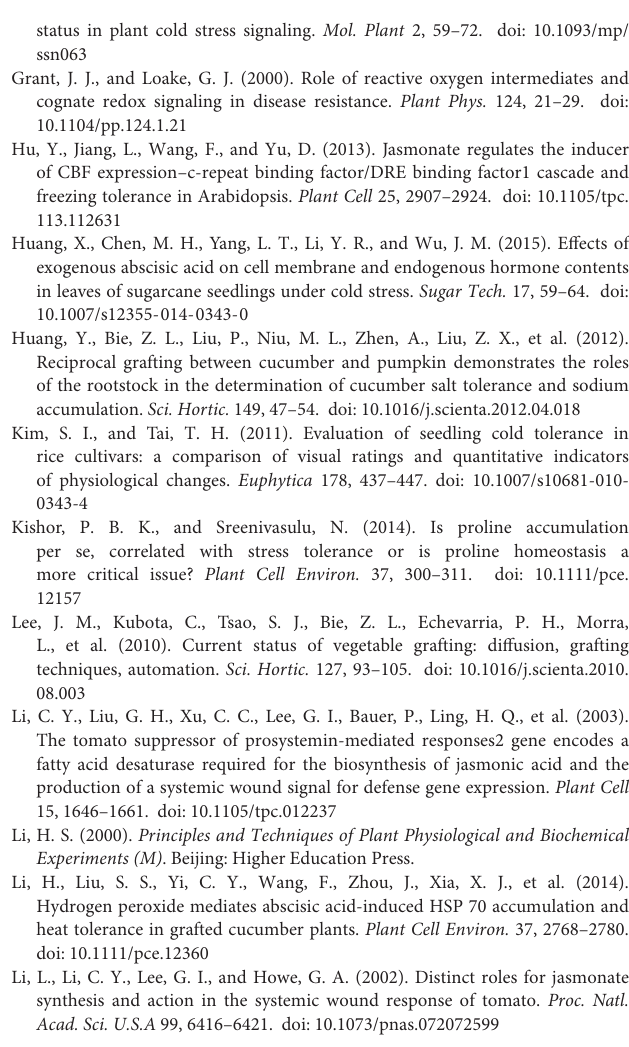
Supplementary Table 10 | KEGG enrichment of 620 upregulated CmoDEGs in roots. rootstock leaves and